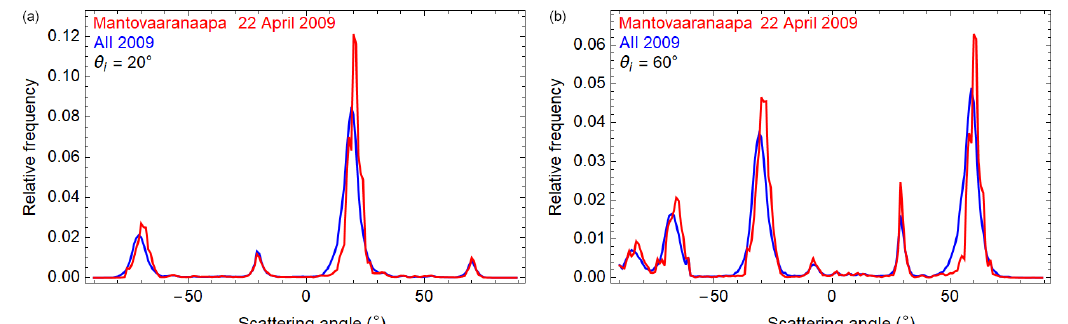
Figure 15. Mantovaaranaapa on 22 April 2009.